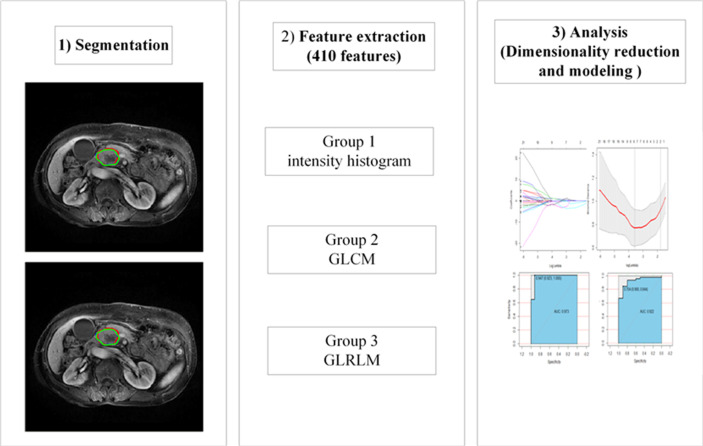
The workflow of radiomic. GLCM, gray level co-occurrence matrix; GLRLM, gray-level run-length matrix.